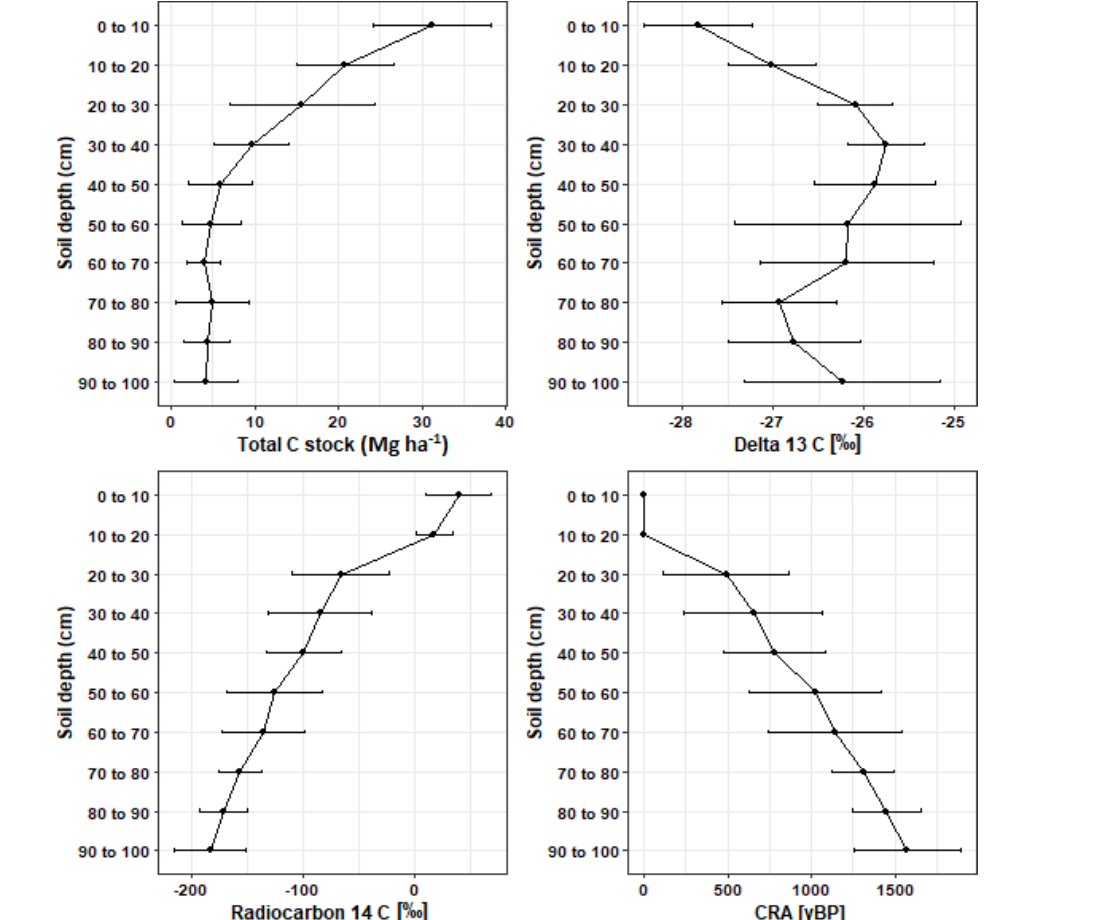
Figure 2. The mean ± SD changes in total C stock (Mgha − 1 ), δ 13 C [‰], (cid:49) 14 C [‰], and conventional radiocarbon age (CRA) [yrBP] with soil